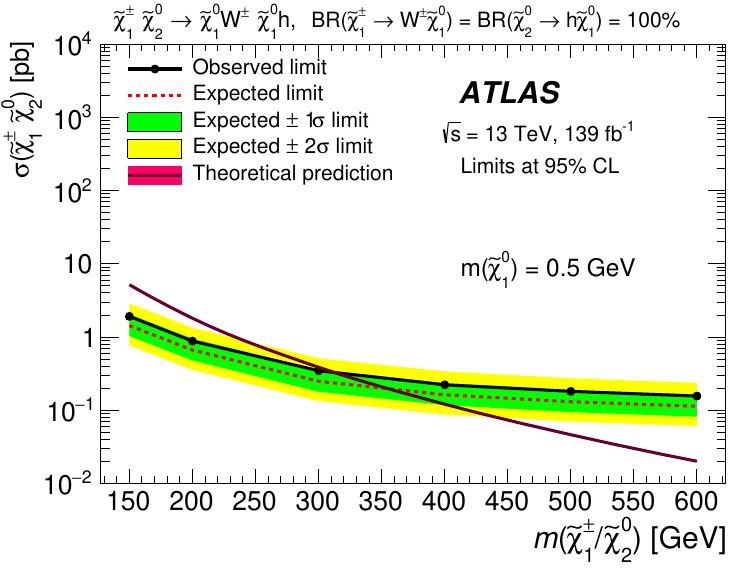
Figure 9 . Expected and observed 95% CL exclusion upper limits on the production cross-section ! W (cid:6) ~ (cid:31) 0 of ~ (cid:31) (cid:6) ~ (cid:31) 0 h ~ (cid:31) 0 as a function of m (~ (cid:31) (cid:6) 1 2 1 1